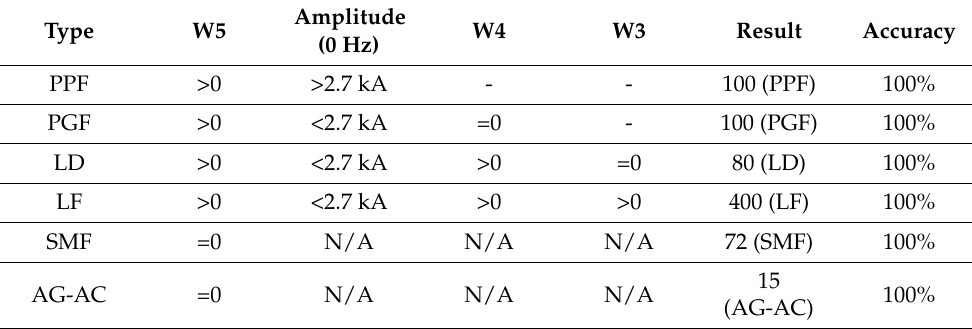
Table 3. Results for different fault types with wavelet